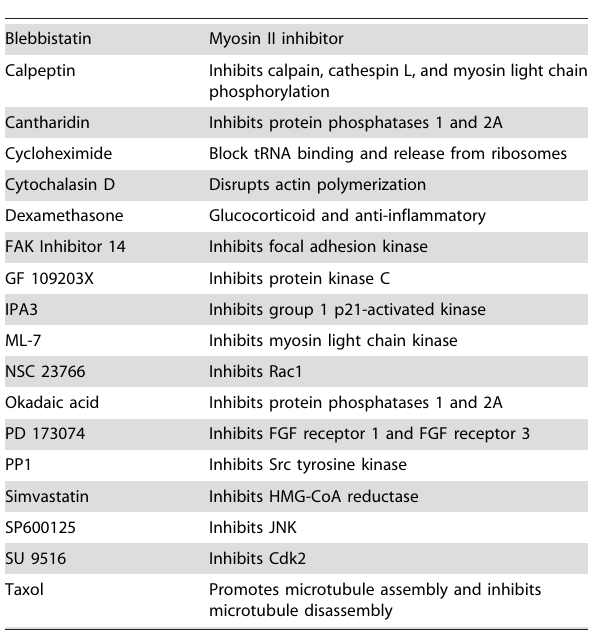
Table 2. Molecular actions of tested